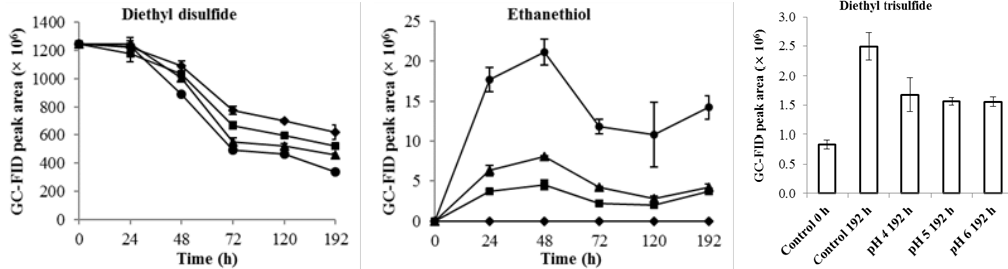
Figure 3. pH effect on the interconversion of diethyl disulfide and ethanethiol, control ( ◆ ), pH 4.0 ( ■ ), pH 5.0 ( ▲ ), pH 6.0 (●).